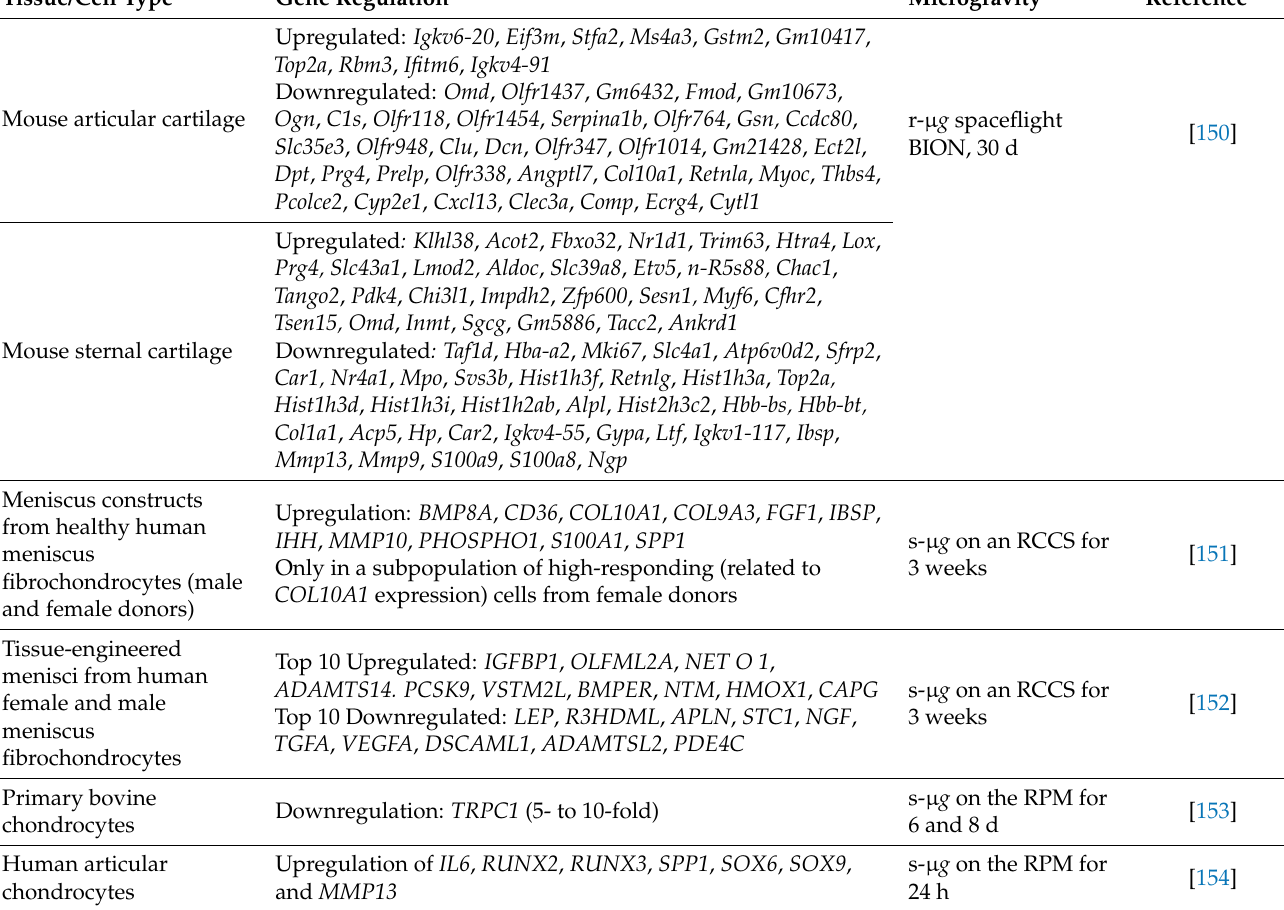
Table 6. Changes in gene regulation of cartilage exposed to microgravity